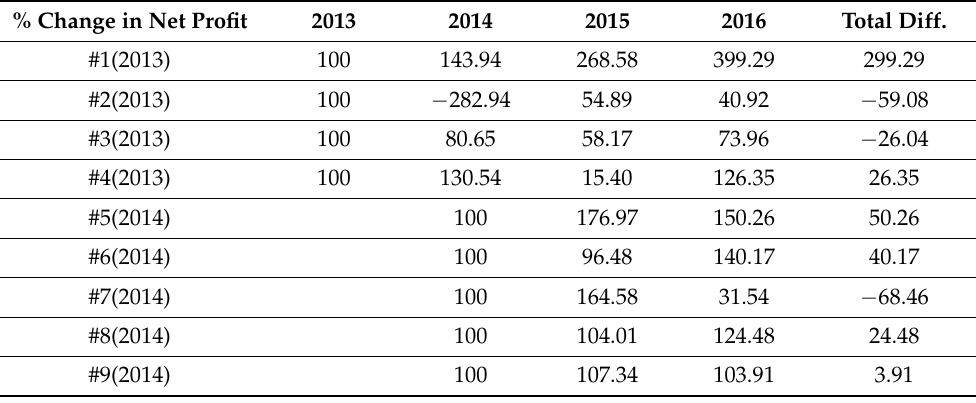
Table 2. Percent change in net profit over the studied years for the nine examined samples; the split year is mentioned in parentheses in the first column. The split year net profit is arbitrarily taken as being equal to a 100